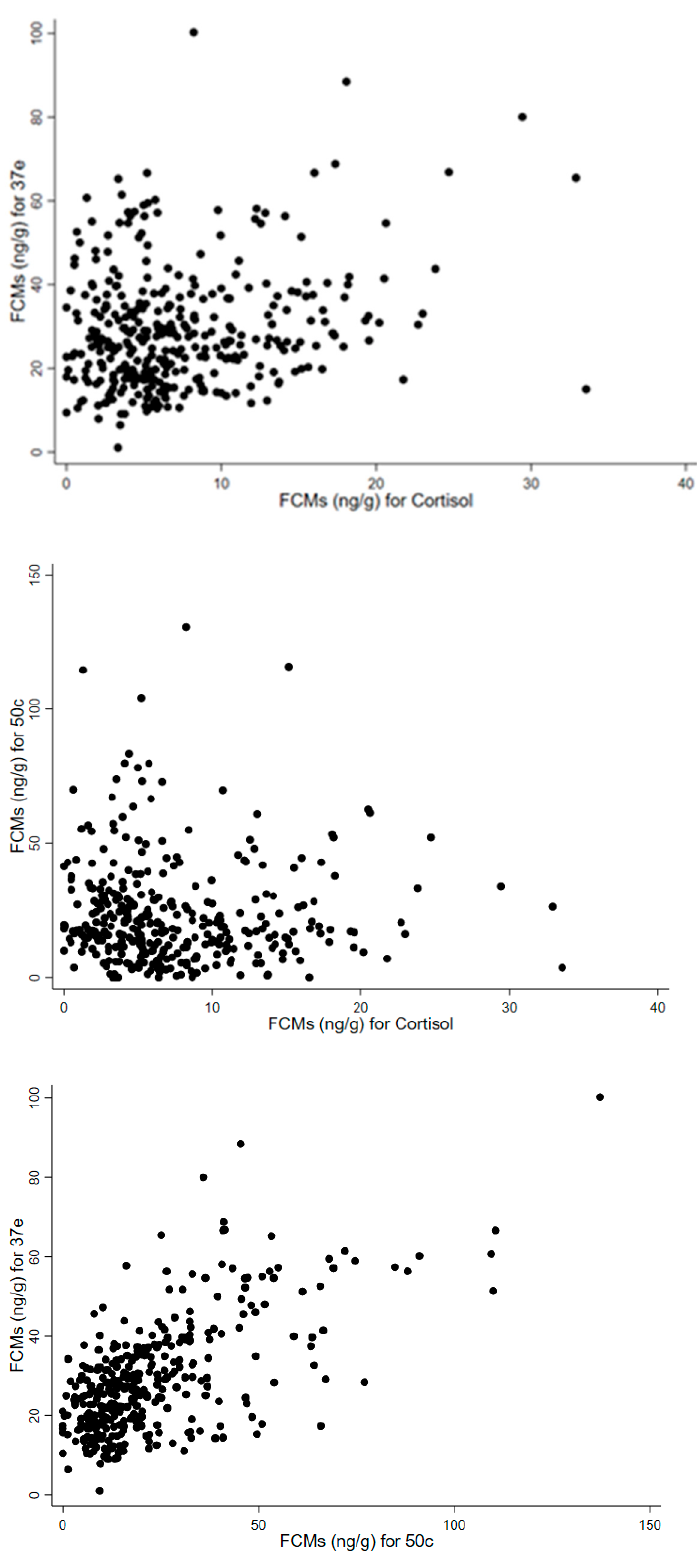
Figure 8. Scatterplots correlating FCM (faecal cortisol metabolite) values (ng/g) measured with cortisol, 37e (5 α -pregnane-3 β ,11 β ,21-triol-20-one) and 50c (tetrahydrocorticosterone) EIAs (enzyme immunoassay) conducted over a period of 12 months (defecations: n = 351).